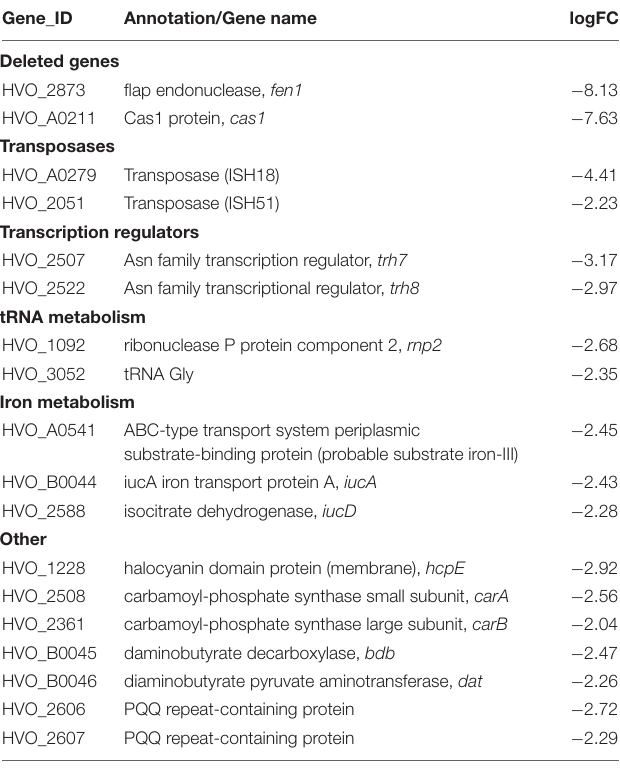
TABLE 2 | RNA expression profile of the (cid:49) cas1 (cid:49) fen1 deletion mutant compared to the wild-type.